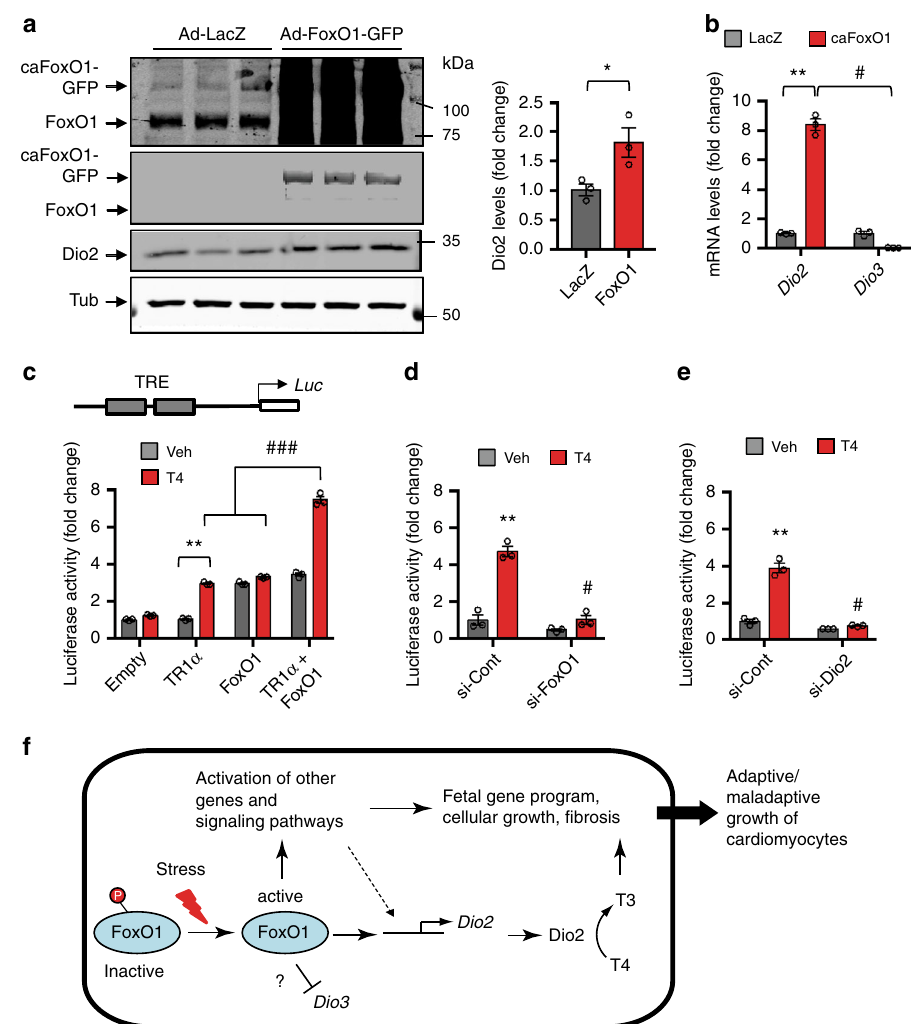
Fig. 7 FoxO1-dependent induction of Dio2 governs TH-responsive gene expression in hypertrophic cardiomyocytes. a , b caFoxO1 overexpression in NRVM markedly induced Dio2 protein ( a ) and mRNA ( b ) levels but repressed Dio3 gene expression ( b ). c Schematic of thyroid hormone receptor (THR)- responsive reporter plasmid harboring two thyroid hormone-responsive elements (TREs). Note that co-expression of caFoxO1 and THR α 1 (TR α 1), but not either alone, in HEK293 cells resulted in robust and synergistic activation of reporter activity only in the presence of T4 ( n = 3). d , e THR-responsive reporter activity in NRVM transfected with control or indicated gene-speci fi c ( FoxO1 and Dio2 ) siRNAs. Note that compared with control siRNA-treated cells, selective knockdown of FoxO1 ( d ) and Dio2 ( e ) signi fi cantly attenuated T4-dependent activation of luciferase activity. In all panels, data are depicted as mean ± SEM ( n = 3 independent experiments). * p < 0.05 vs control; ** p < 0.001 vs control; # p < 0.001 vs control; ### p < 0.0001 vs control. Statistical analyses were conducted using a two-tailed, unpaired Student ’ s t -test. f Working model for FoxO1 ’ s role in adaptive and maladaptive hypertrophic growth of cardiomyocytes. In response to oxidative- and TAC-induced (Stress), activation of FoxO1 and FoxO1-dependent reciprocal regulation of Dio2 and Dio3 in cardiomyocytes is a key driver for subsequent activation of other transcriptional and signaling programs to activate fetal and fi brotic genes, which together ultimately lead to adaptive and maladaptive hypertrophic growth of neonatal and adult cardiomyocytes,